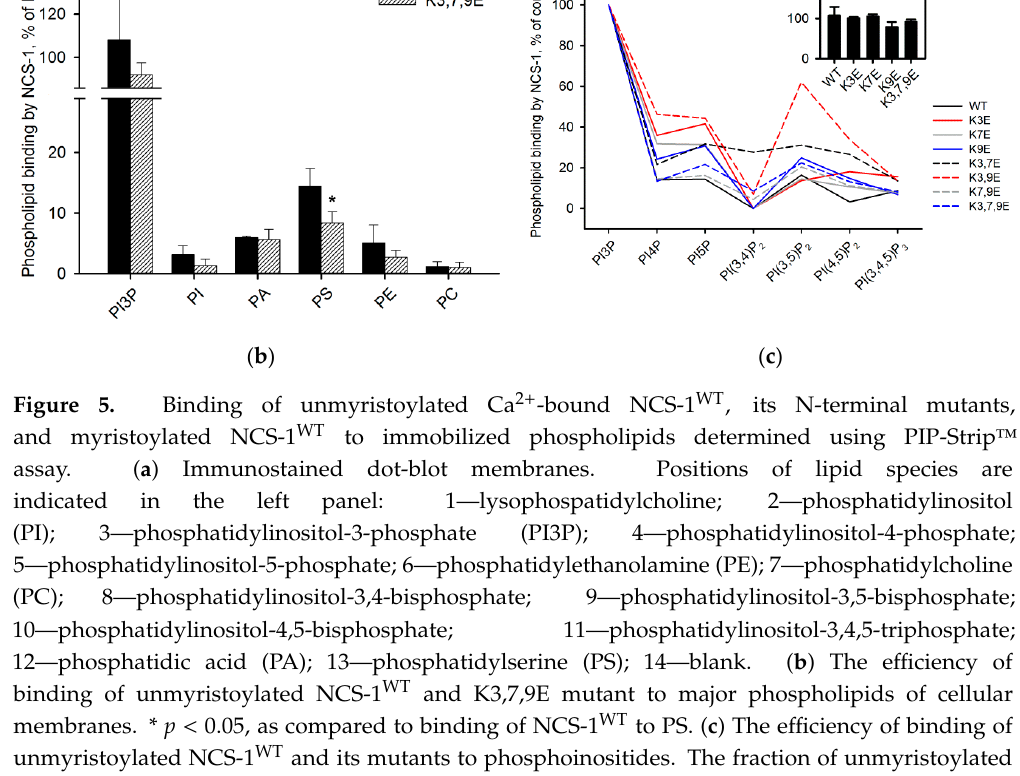
( b ) The e ffi ciency of binding of unmyristoylated NCS-1 WT and K3,7,9E mutant to major phospholipids of cellular membranes. * p < 0.05, as compared to binding of NCS-1 WT to PS. ( c ) The e ffi ciency of binding of unmyristoylated NCS-1 WT and its mutants to phosphoinositides. The fraction of unmyristoylated NCS-1 bound to PI3P in the presence of Ca 2 + was taken as 100% (relative e ffi ciency of PI3P binding by the mutants is shown in